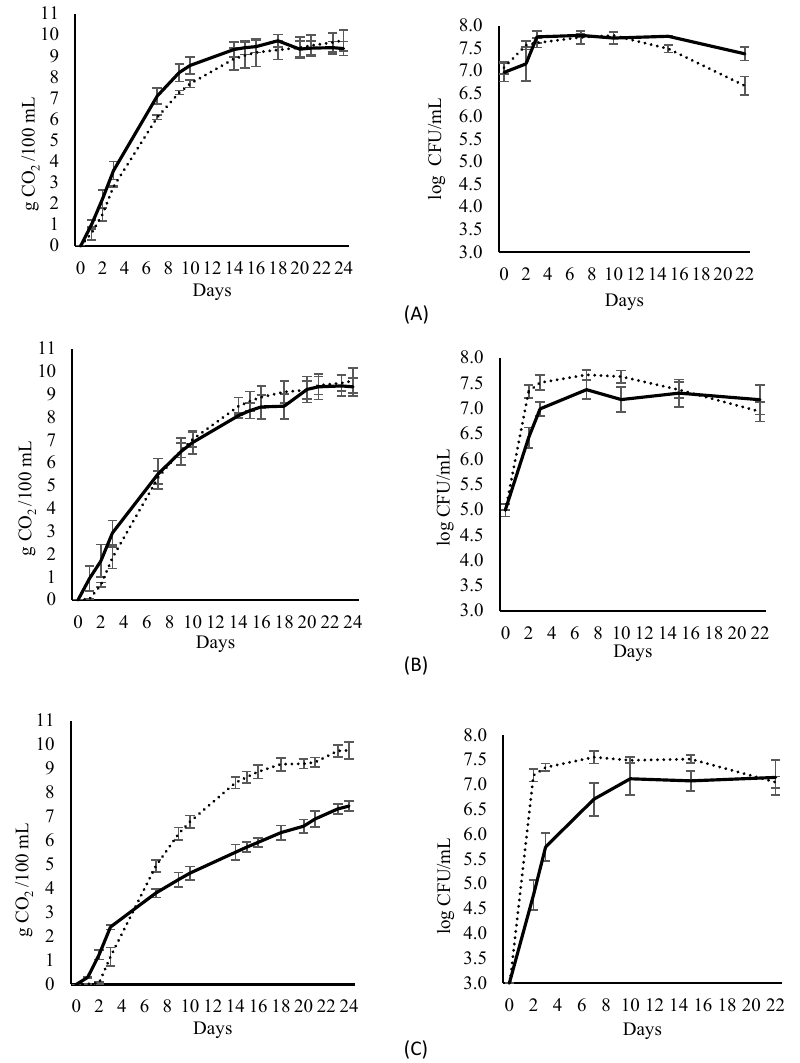
Figure 1. Fermentation kinetics (left panels) and cell growth (right panels) of S. cerevisiae EC1118 in pure (dot line) and mixed culture (full line) with S. japonicus #13. Results relative to the three S. cerevisiae/S. japonicus inoculum ratios are reported. (( A ) ratio 1:1; ( B ) ratio 1:100; ( C ) ratio 1:10,000). Data are means ± standard deviations of two independent experiments, each carried out in duplicate. Where not seen, bars lay within the symbols.